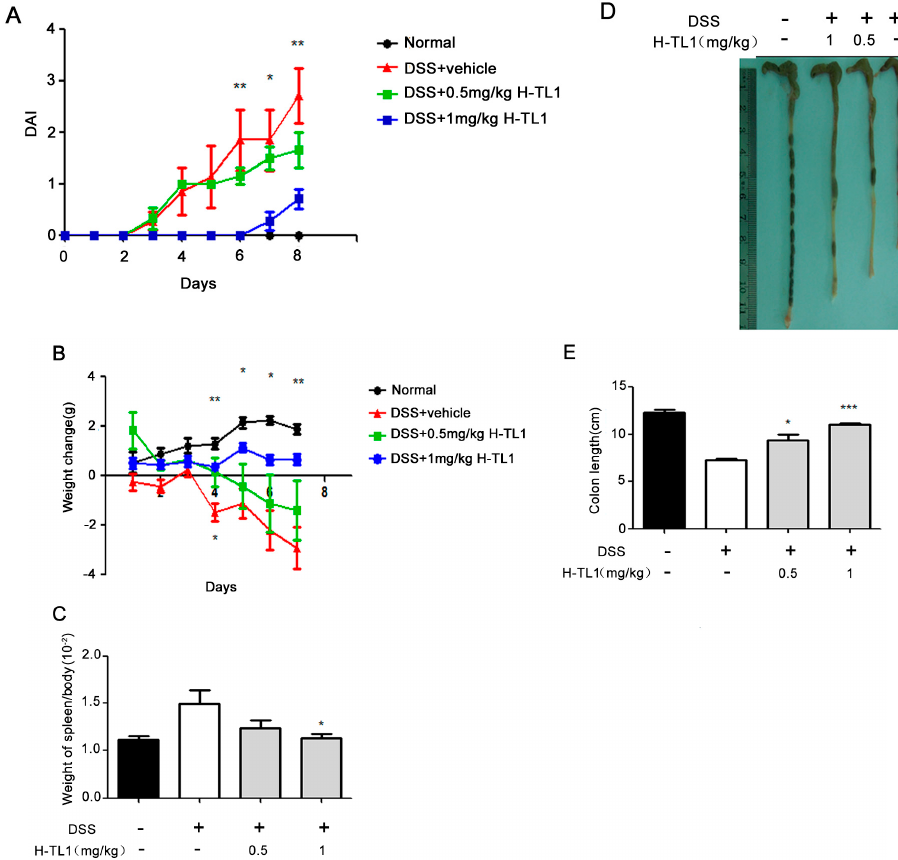
Figure 3. H-TL1 ameliorated DSS-induced colitis: ( A ) Effect of H-TL1 on DAI induced by DSS. DAI (fecal bleeding, diarrhea, and weight loss) was monitored for eight days; ( B ) Effect of H-TL1 on body weight of mice with DSS-induced acute colitis. Values represent means ± SEM ( n = 8), * p < 0.05 and ** p < 0.01 vs. DSS group (upper panels) for group treated with H-TL1 (1 mg/kg); * p < 0.05 vs. DSS group (lower panels) for group treated with H-TL1 (0.5 mg/kg); ( C ) Effects of H-TL1 on spleen/body weight ratio in mice with DSS-induced acute colitis; ( D , E ) Effects of H-TL1 on colon length in mice with DSS-induced acute colitis. The DSS-negative group was considered normal. In ( A , C , E ), values represent means ± SEM ( n = 8), * p < 0.05, ** p < 0.01, and *** p < 0.001 vs. DSS group.